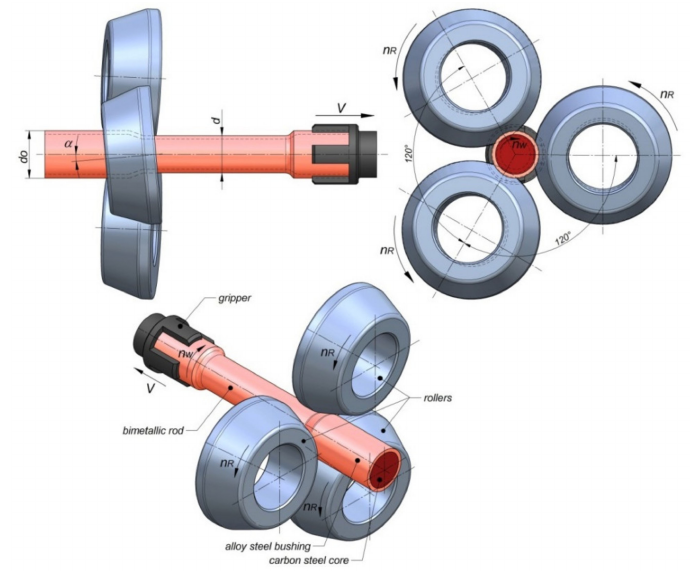
Figure 1. Schematic of skew rolling of bimetallic rods.